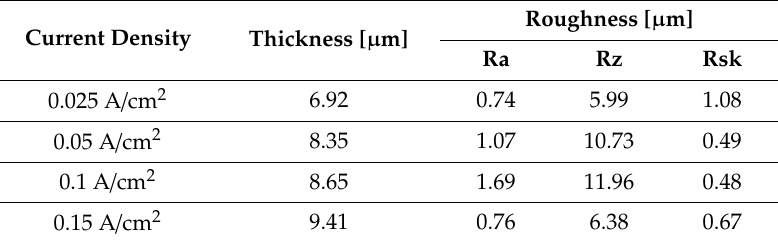
Figure 6. Morphology of the PEO coating prepared in the electrolyte with 15 g / L of Na 3 PO 4 · 12H 2 O and current density of 0.025 A / cm 2 ( a ), 0.05 A / cm 2 ( b ), 0.1 A / cm 2 ( c ) and 0.15 A / cm 2 ( d ). Table 6. Thickness and roughness parameters of the PEO coatings prepared in the electrolyte with 15 g / L of Na 3 PO 4 · 12H 2 O.